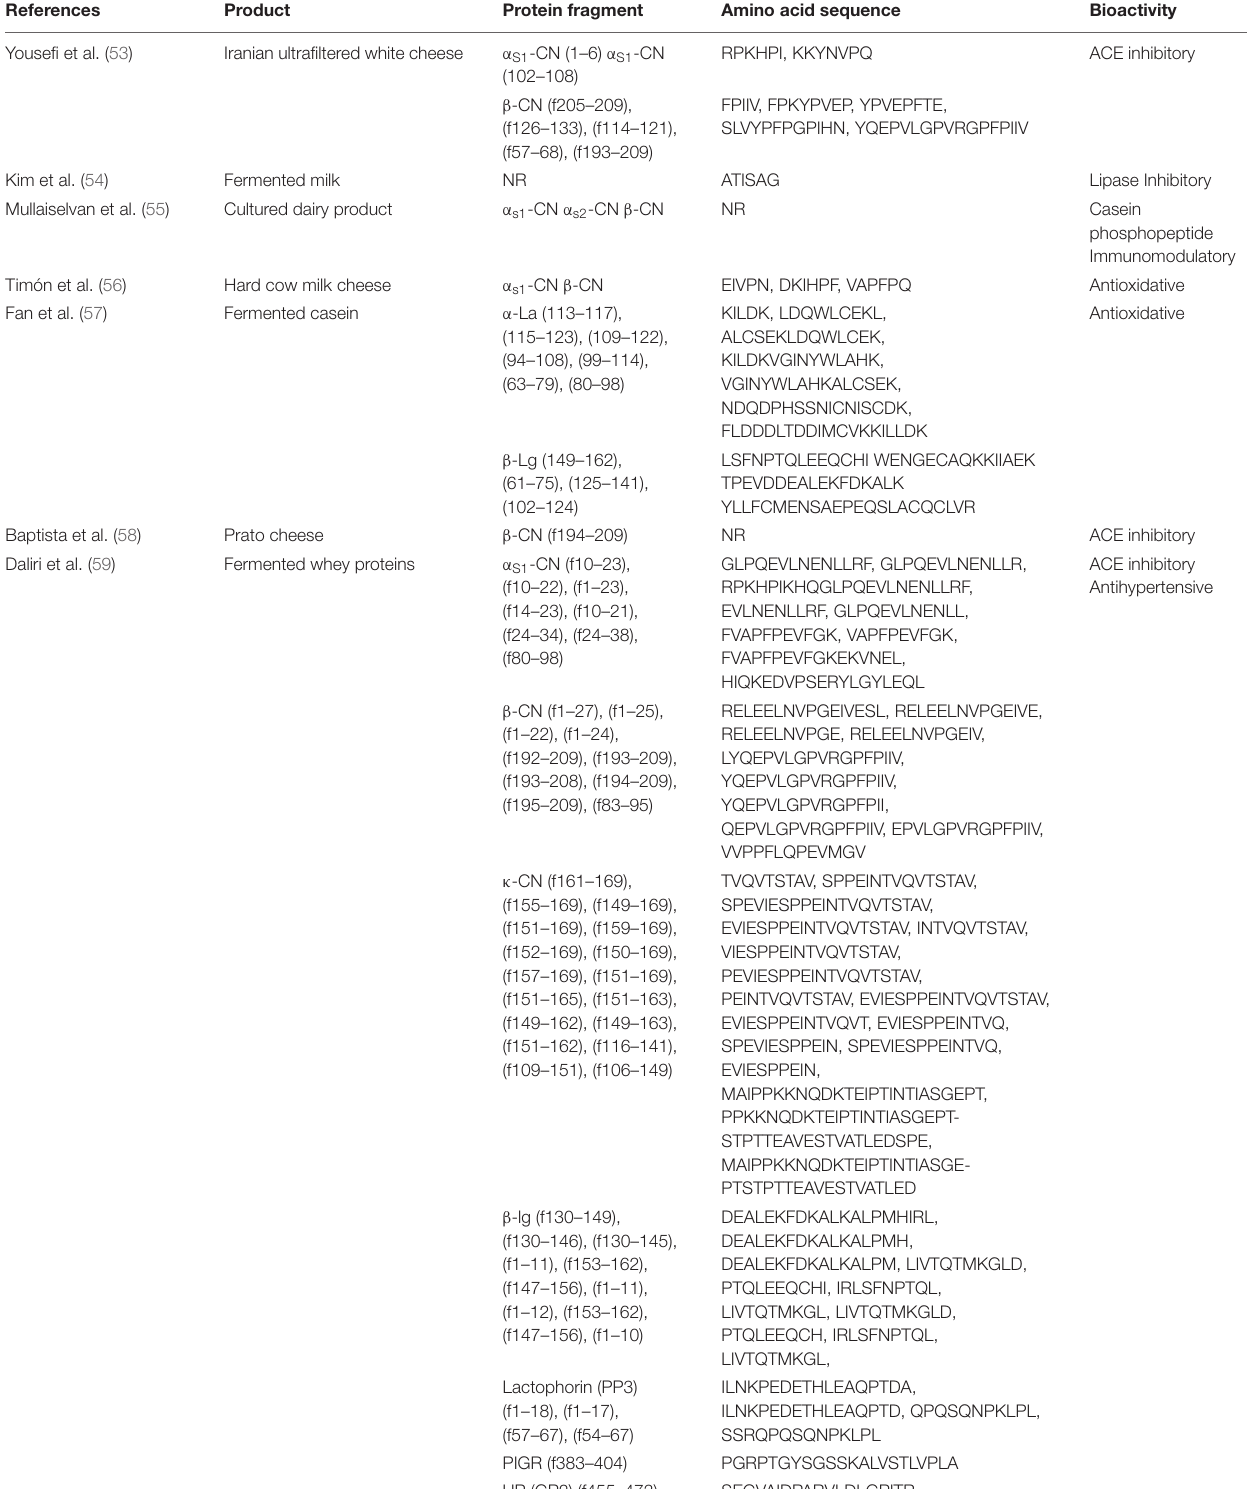
TABLE 2 | Bioactive peptides identified in fermented dairy